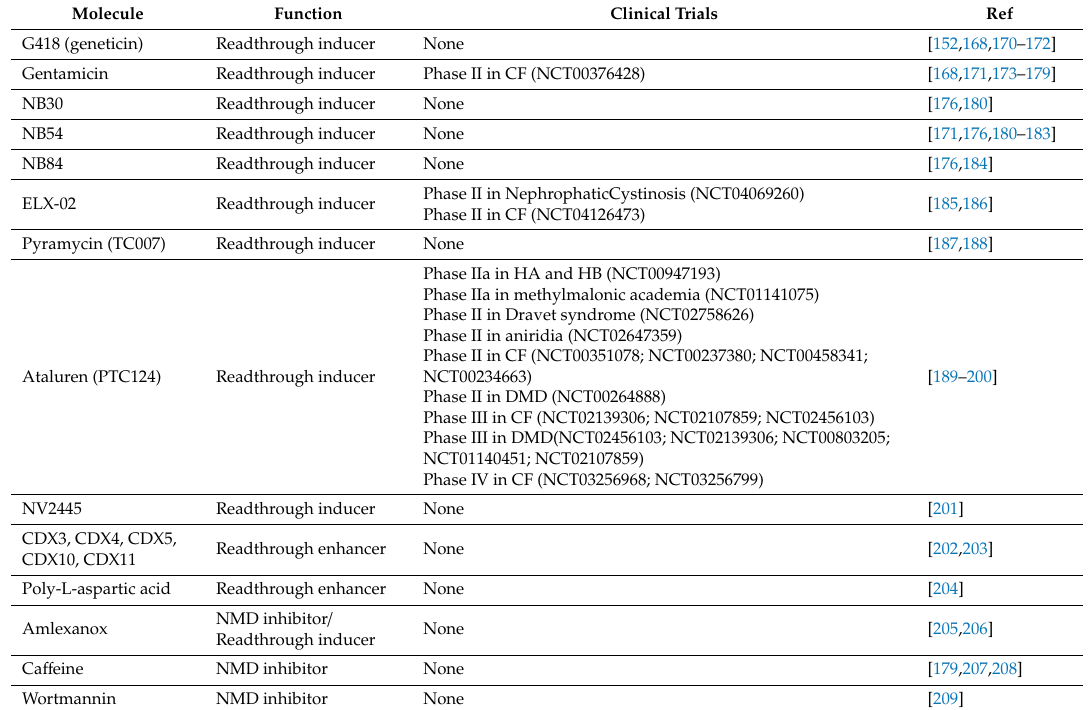
Table 2. State-of-the-art of the nonsense suppression